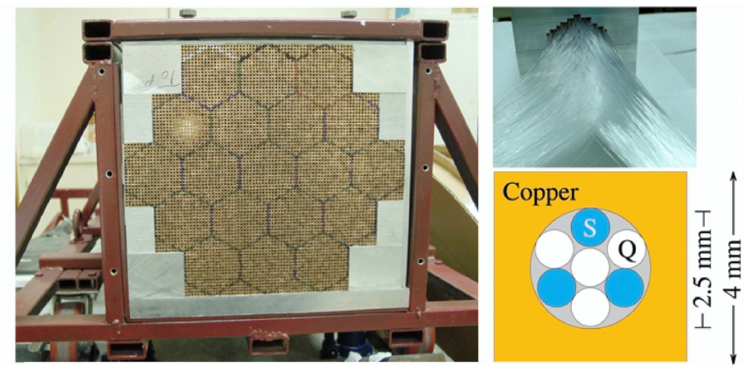
Figure 5. The DREAM calorimeter. See text for